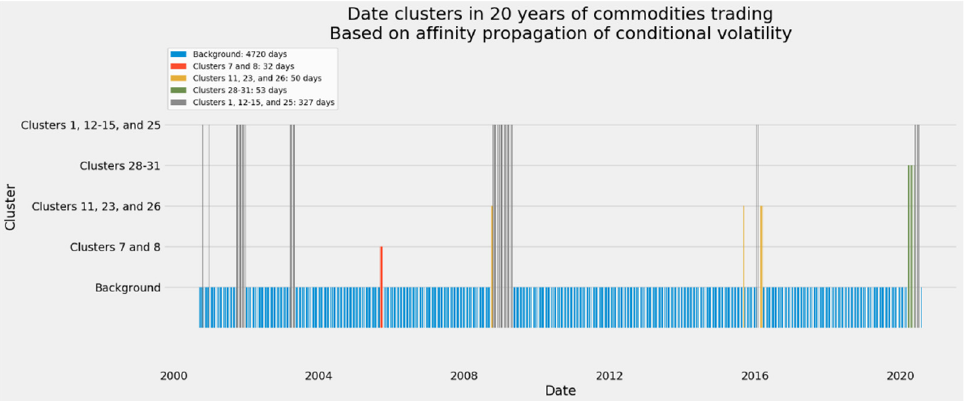
Figure 32. Affinity propagation of energy-related markets—A simplified timeline showing the 15 smallest clusters, further subdivided into four groups of interest.